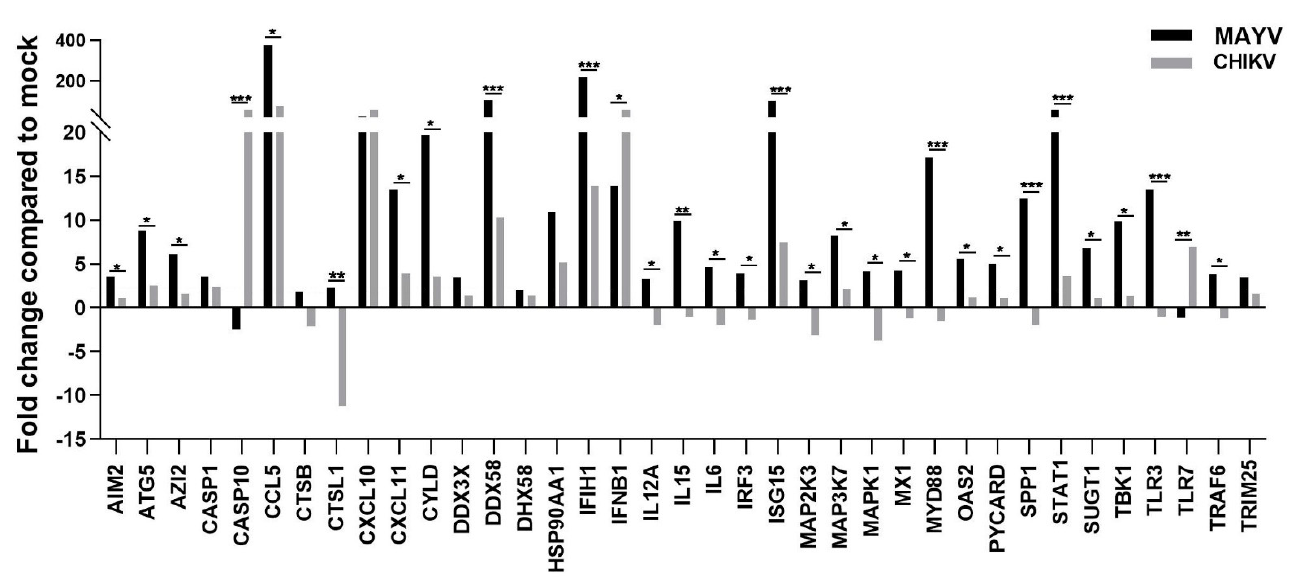
Figure 3. MAYV induces a strong antiviral response in human astrocytes. RNA extract from infected human astrocytes (MOI 5) at 48 hpi were subjected to RT 2 Profiler PCR array. The modulation of antiviral response genes following MAYV or CHIKV infection is expressed as function of that with mock-infected cells. The mean values are represented by each point and two experiments ( n = 2) was performed in triplicate. The unpaired t -test * p < 0.05, ** p < 0.01, *** p < 0.001, was employed to determine statistical significance between data obtained with MAYV or CHIKV-infected cells.